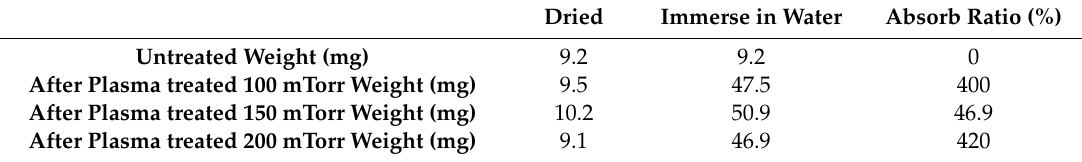
Figure 2. Aging effect of the plasma-treated polyethylene terephthalate (PET) surface hydrophilicity. Table 2. The wettability of polypropylene (PP) nonwoven after treatment (pre-treatment is hydrophobic) (by absorption H 2 O).